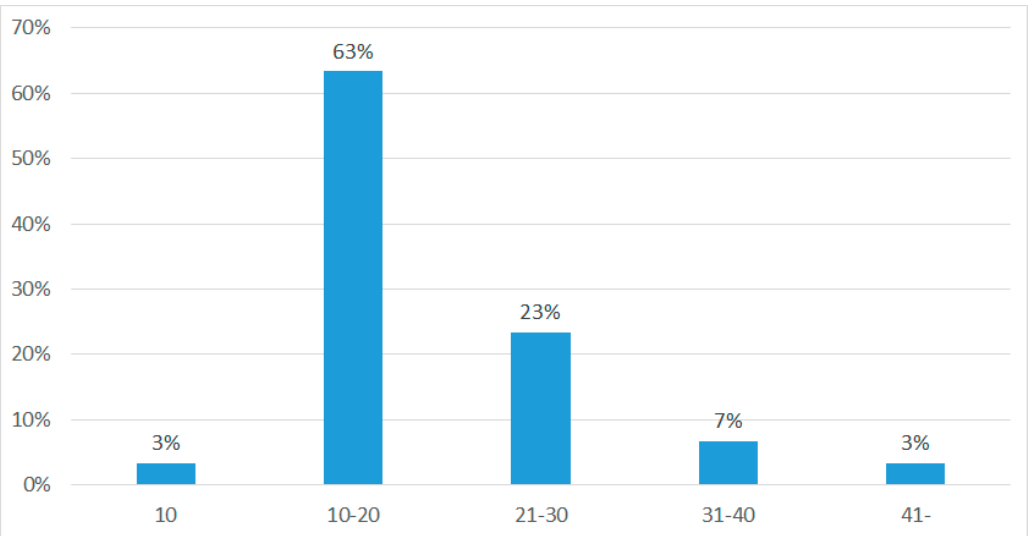
Figure 3. Structure of the Delphi expert study participants by job experience; own elaboration based on the conducted research.